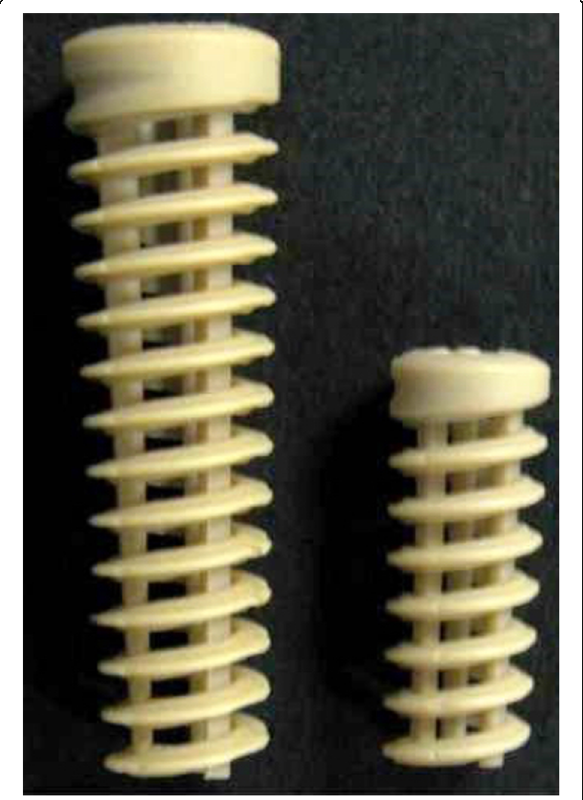
Fig. 1 The BIOSURE HEALICOIL PK interference screw implant. The implant is characterized by three central columns and an open thread architecture allowing bone ingrowth into in between threads and screw